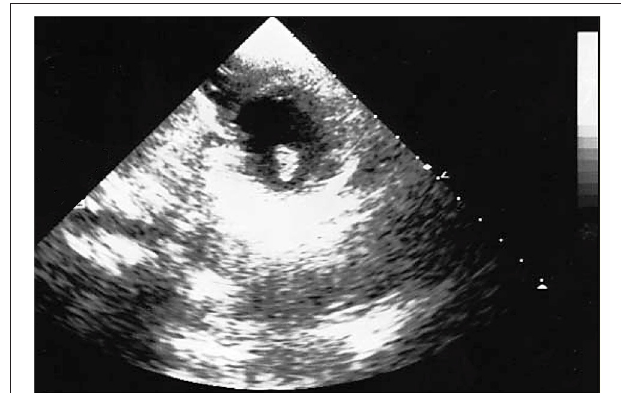
FIGURE 1 | Echocardiographic image: solid neoplasm floating in the left ventricle outflow chamber, connected to the anterolateral papillary muscle of the left ventricle and characterized by homogeneous density, large base implant, and regular margins.